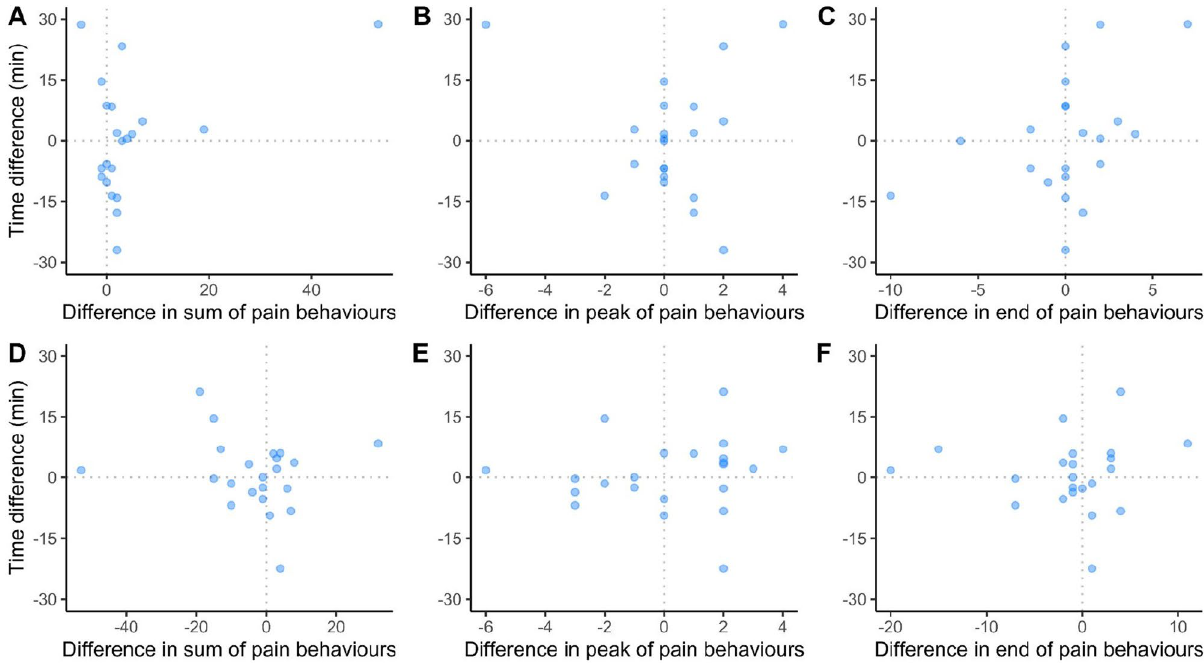
Figure 2. Correlations between aversion results and pain behaviours for Trial 1 ( A – C ) and Trial 2 ( D – F ). Correlations were tested for the ‘sum’ (pain behaviours displayed over the whole treatment duration, A , D ), ‘peak’ (highest occurrence, B , E ) and ‘end’ (over the last two hours, C , F